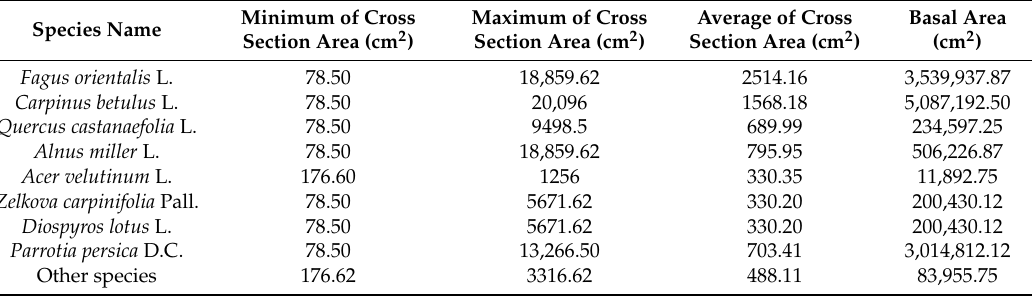
Table 1. Statistical table displays the species distribution based on inventory